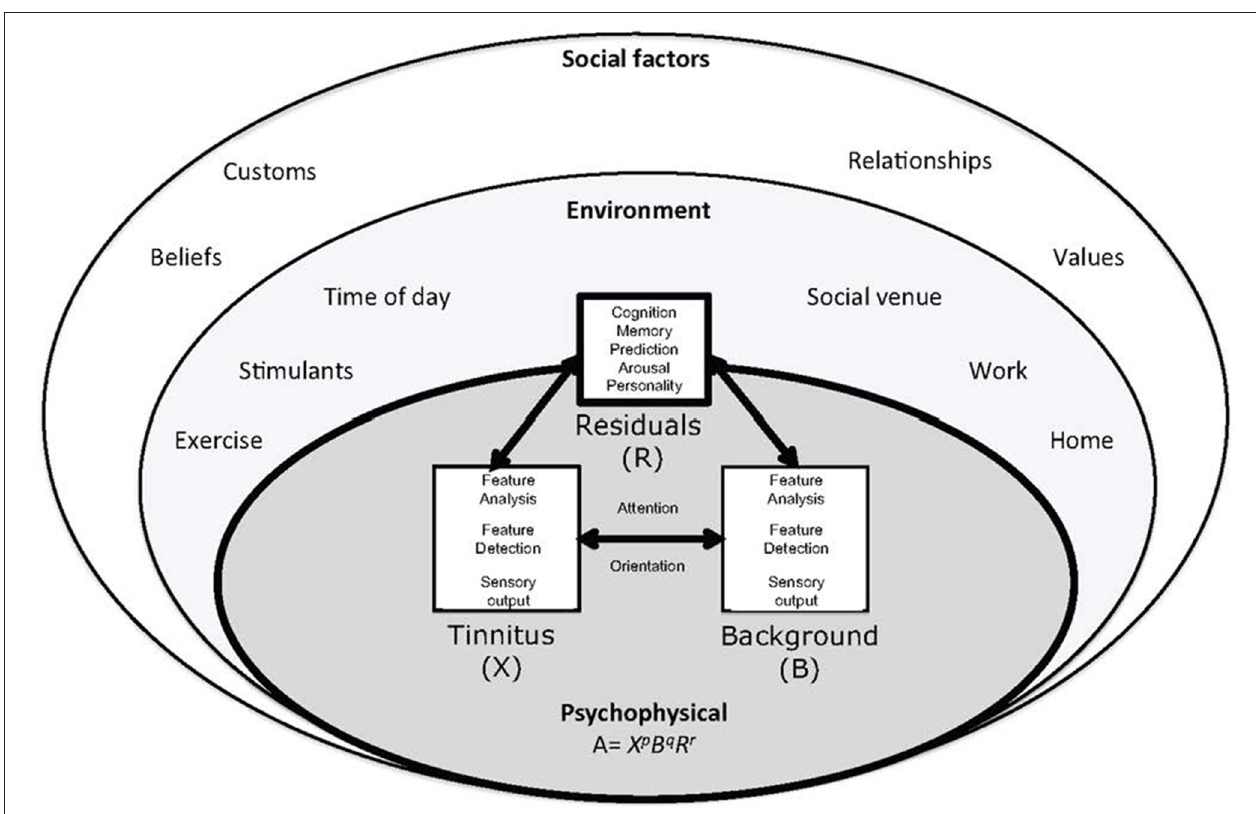
FIGURE 5 | The ecological model of tinnitus. It consists of a psychophysical core described by adaptation level theory. In adaptation level theory tinnitus and background sound perception are under influence of individual psychology factors classified as “residuals.” These factors are influenced by the environment and social context. Helson ( 179) expressed this relationship mathematically: A = X p B q R r . The adaptation level (A) is the weighted product of: X, the intensity of tinnitus signal, B , intensity of background neural activity, and R , intensity of residual components (e.g., memory, arousal, and personality). The weighting coefficients p, q , and r determine the relative contributions of components to adaptation level. These factors are under the influence of environmental and psychosocial factors [( 75) with permission of the